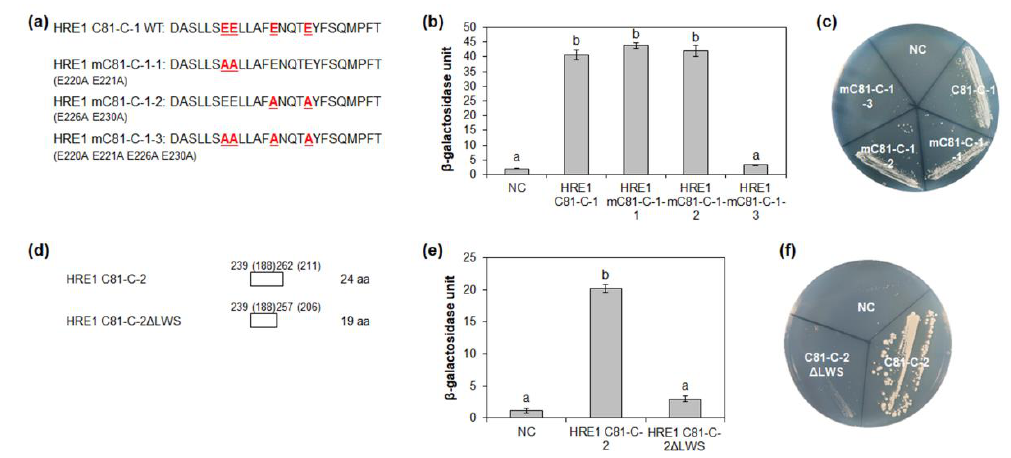
Figure 6. Identification of the amino acid residues responsible for transactivation activity. ( a ) The amino acid sequences of HRE1 β C81-C-1 and its site-directed mutated sequences for the analysis of transactivation activity in yeast. ( b , e ) Quantitative β -galactosidase ONPG assay. The transactivation activities were quantified by measuring the β -galactosidase activity in yeast extract. The experiments of each technical replicate were performed in triplicate. The data shown are the means ± S.D. ( n = 3). Similar results were obtained from at least three biological replicates, with one shown here. The data were analyzed with one-way ANOVA using Tukey’s multiple comparison test. Di ff erent letters indicate significant di ff erences ( p < 0.05). ( c , f ) Yeast growth assay. Yeast transformants were grown on SM-Trp / -Ura. ( d ) The schematic maps of HRE1 β C81-C-2 and its partial fragment for the analysis of transactivation activity in yeast. The numbers in parentheses represent the position in HRE1 α . In ( b , c , e , f ), pBD-GAL4 vector itself was used as a negative